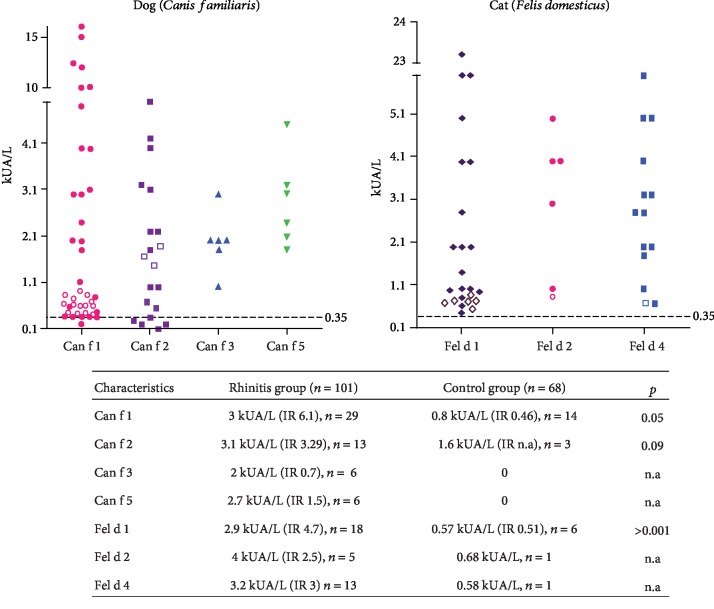
Concentration of dog and cat allergenic components. Patients from the rhinitis group (stuffed) and control group (empty) with sIgE to molecular components. The median and interquartile range (IQR) for each allergenic component among subjects with (+) sIgE over 0.35 kUA/L. n.a: not applicable.